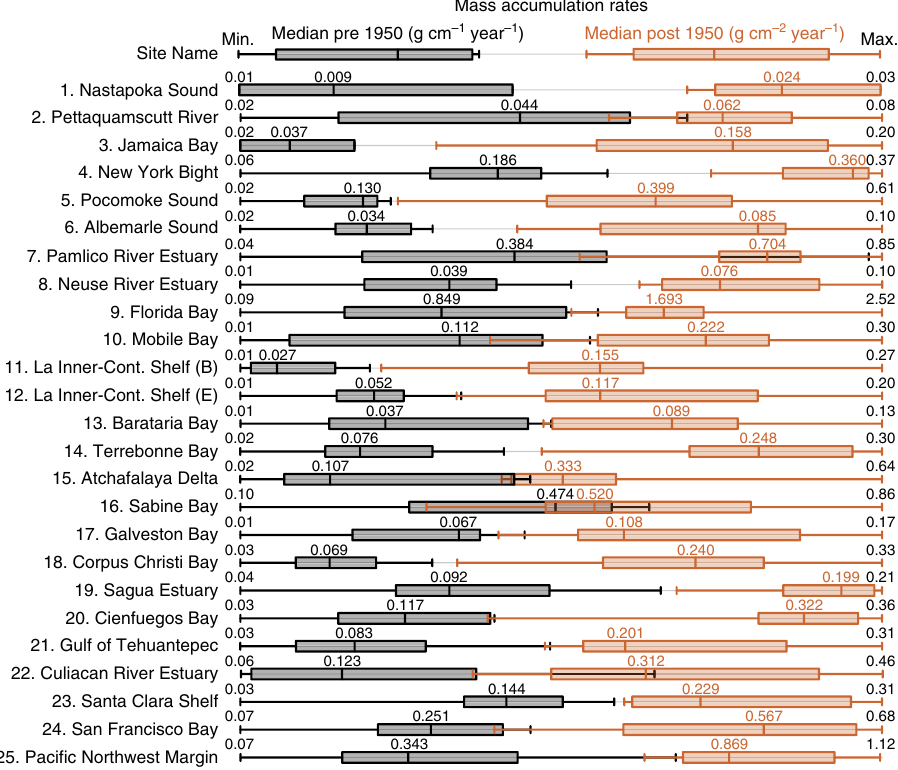
Fig. 4 Summaries of pre and post 1950 mass accumulation rate bins. The post 1950 median mass accumulation rate (MAR; brown) is higher than the pre 1950 median MAR at all sites (black; enumerated). The boxes represent the fi rst and third quartiles and the whiskers show the minimum and maximum MAR for the pre and post 1950 bins. Upper and lower extreme MAR values for the entire time series are enumerated for each site. See Supplementary Data 2 for details.